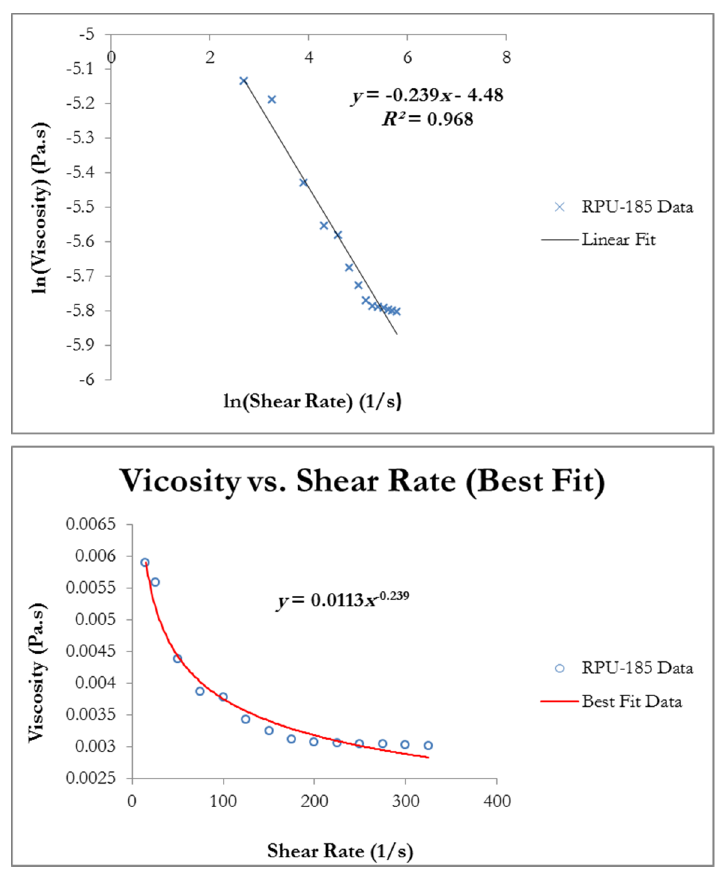
Figure 4. Viscosity plotted against shear rate for rotating MBR system